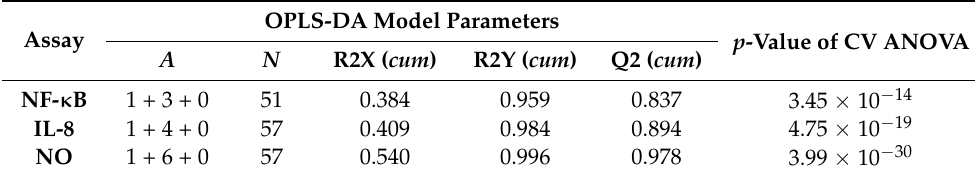
Table 1. OPLS-DA model parameters and p -values of CV ANOVA of the OPLS-DA models generated from CD-processed LC-HRMS data and pharmacological assay data classified according to the param- eters given in Supplementary Table S2 (extracts classified as moderately active were excluded from the models). A : number of principal components; N : number of observations; R2X ( cum ): cumulative sum of squares of the entire X explained by all extracted components. R2Y ( cum ): cumulative sum of squares of all the y-variables explained by the extracted components. Q2 ( cum ): cumulative Y variation predicted by the X model for the extracted components, according to